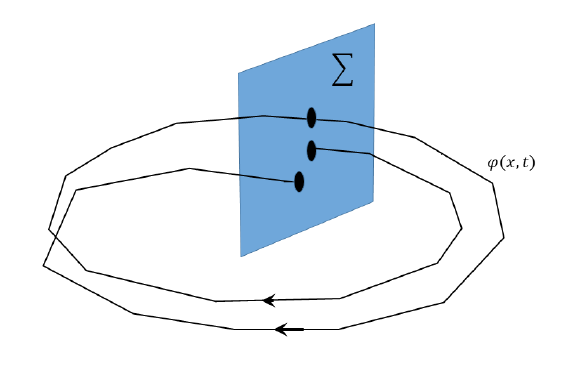
Figure 1. Trajectories and Poincaré map created in Σ